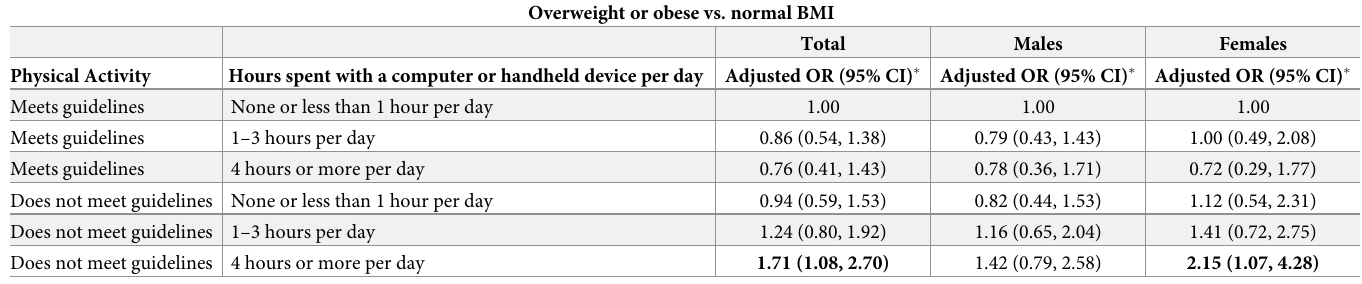
Table 5. Results of logistic regression analysis of the effect modification by physical activity on the association between time spent using a computer or handheld device and overweight. Overweight or obese vs. normal BMI Total Males